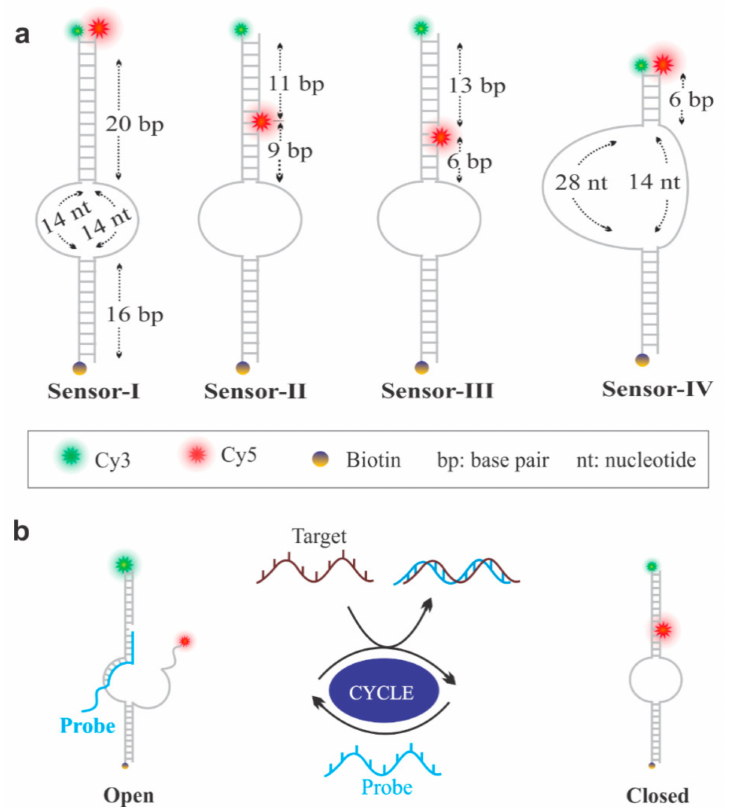
Figure 1. Sensor design and optimization. ( a ) Sensors with donor (Cy3) and acceptor (Cy5) fluorophores. The stem (defined as the number of base pairs formed between the Cy3- and the Cy5-labeled strands between the bulge (central loop) and the Cy5-labeled position) comprised 20, 9, 6, and 6 bp for sensors I, II, III, and IV, respectively. ( b ) Regeneration of sensors to an open (low E FRET ) and a closed state (high E FRET ) by addition of the probe and the target strand,